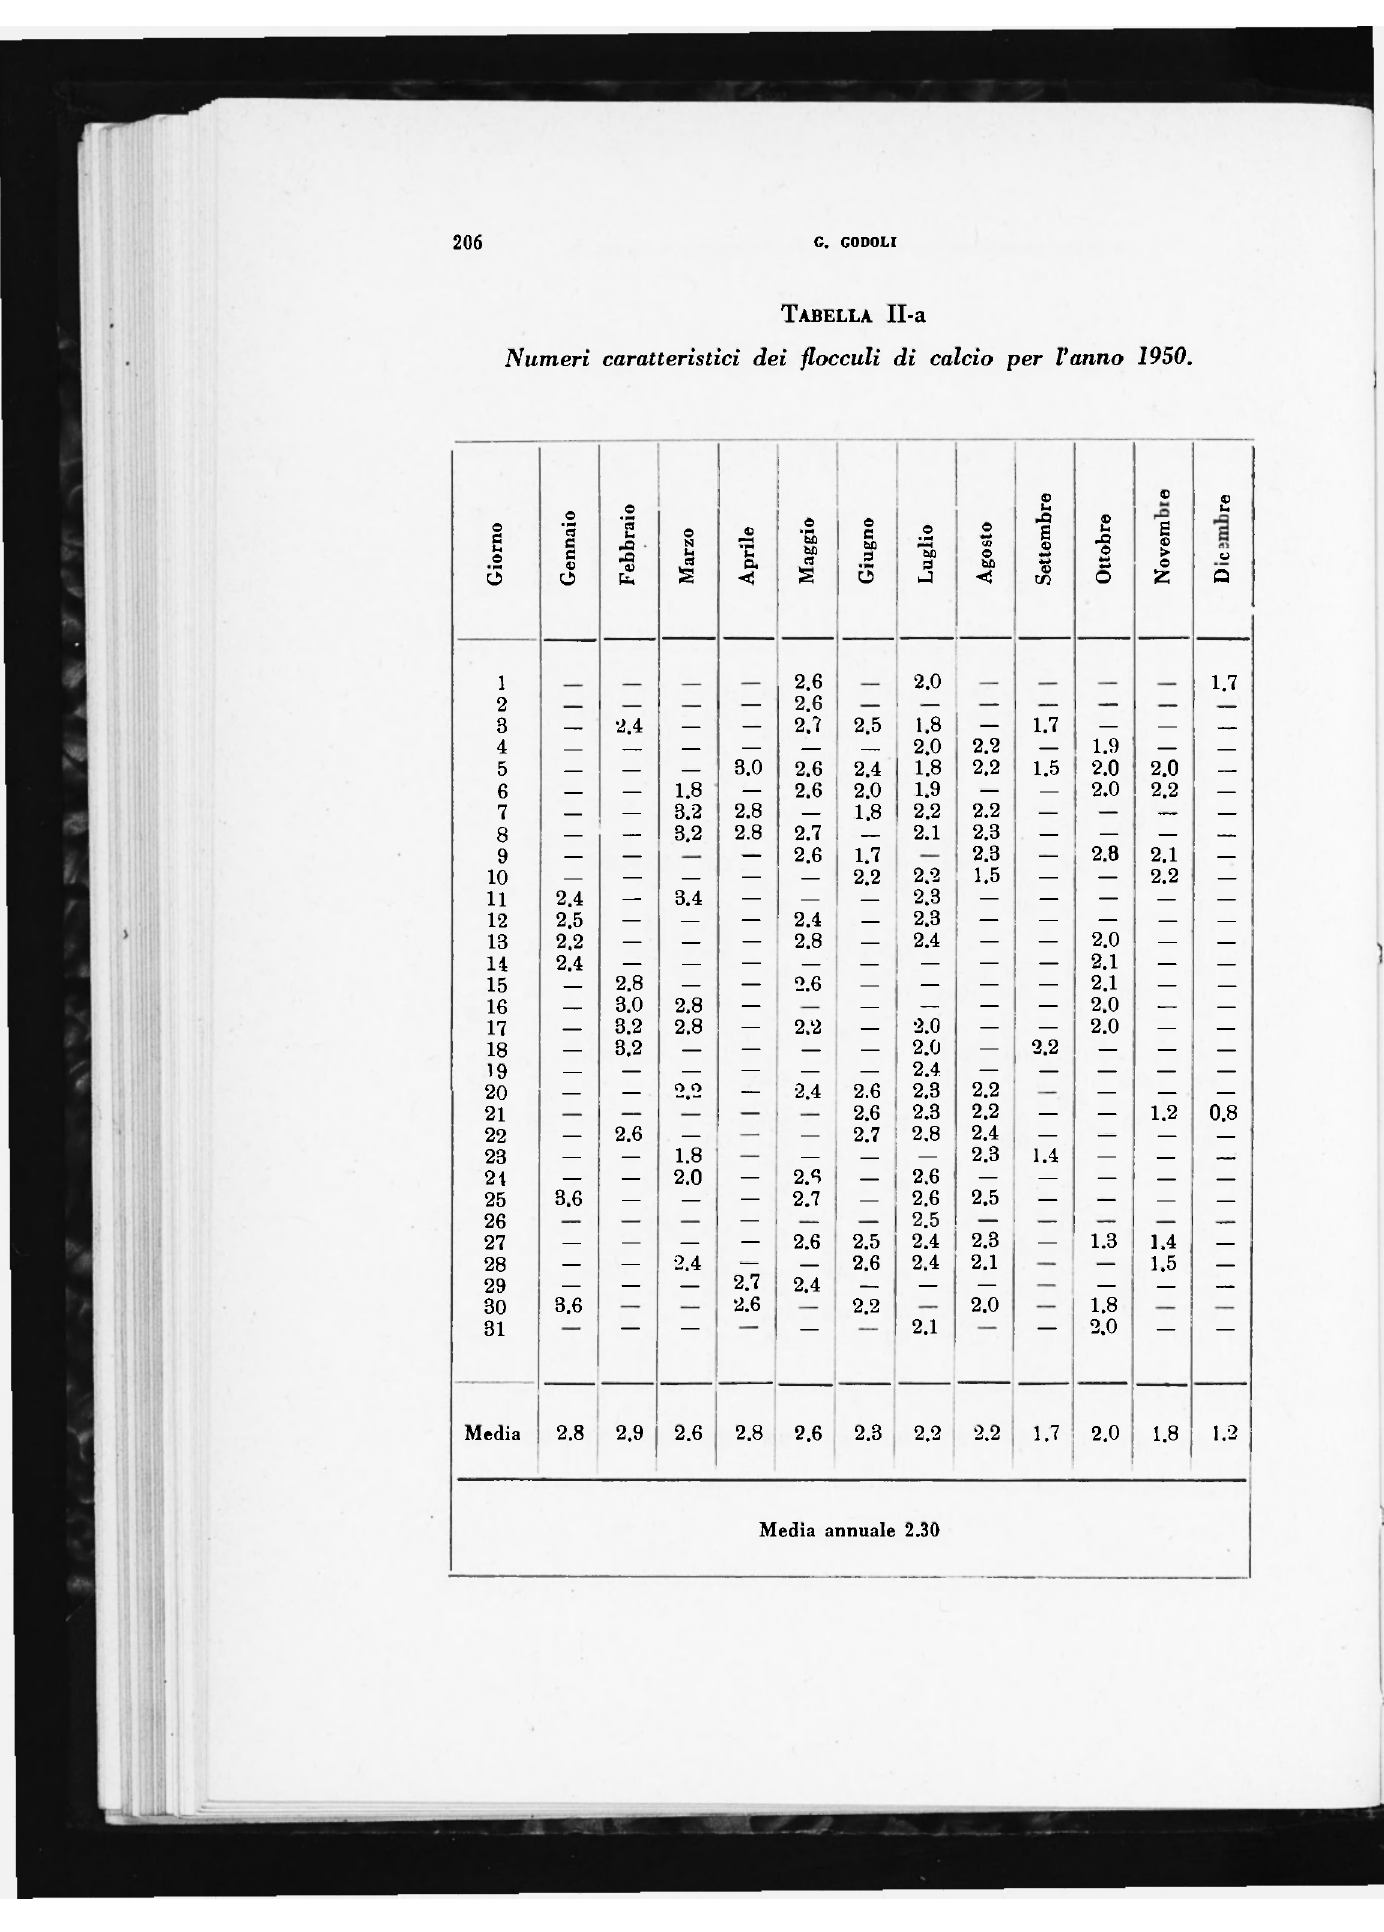
TABELLA IL-a Numeri caratteristici dei flocculi di calcio per l'anno